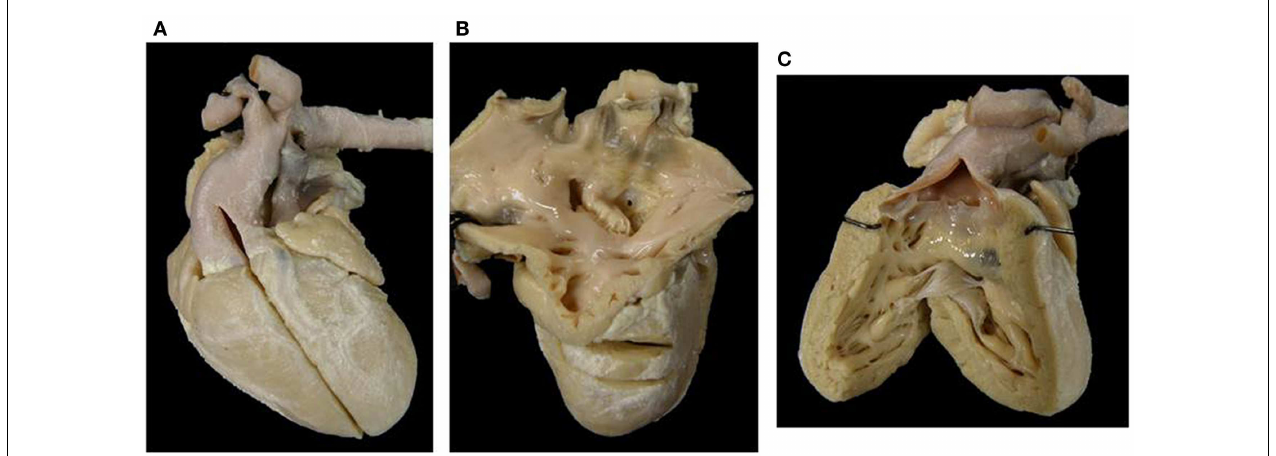
left atrioventricular connection). (C) A good sized, right-sided, morphologically right ventricle ( D -loop) is present from which the aorta takes origin (discordant ventriculo-arterial connection).The pulmonary artery takes origin from the left ventricle (not shown).